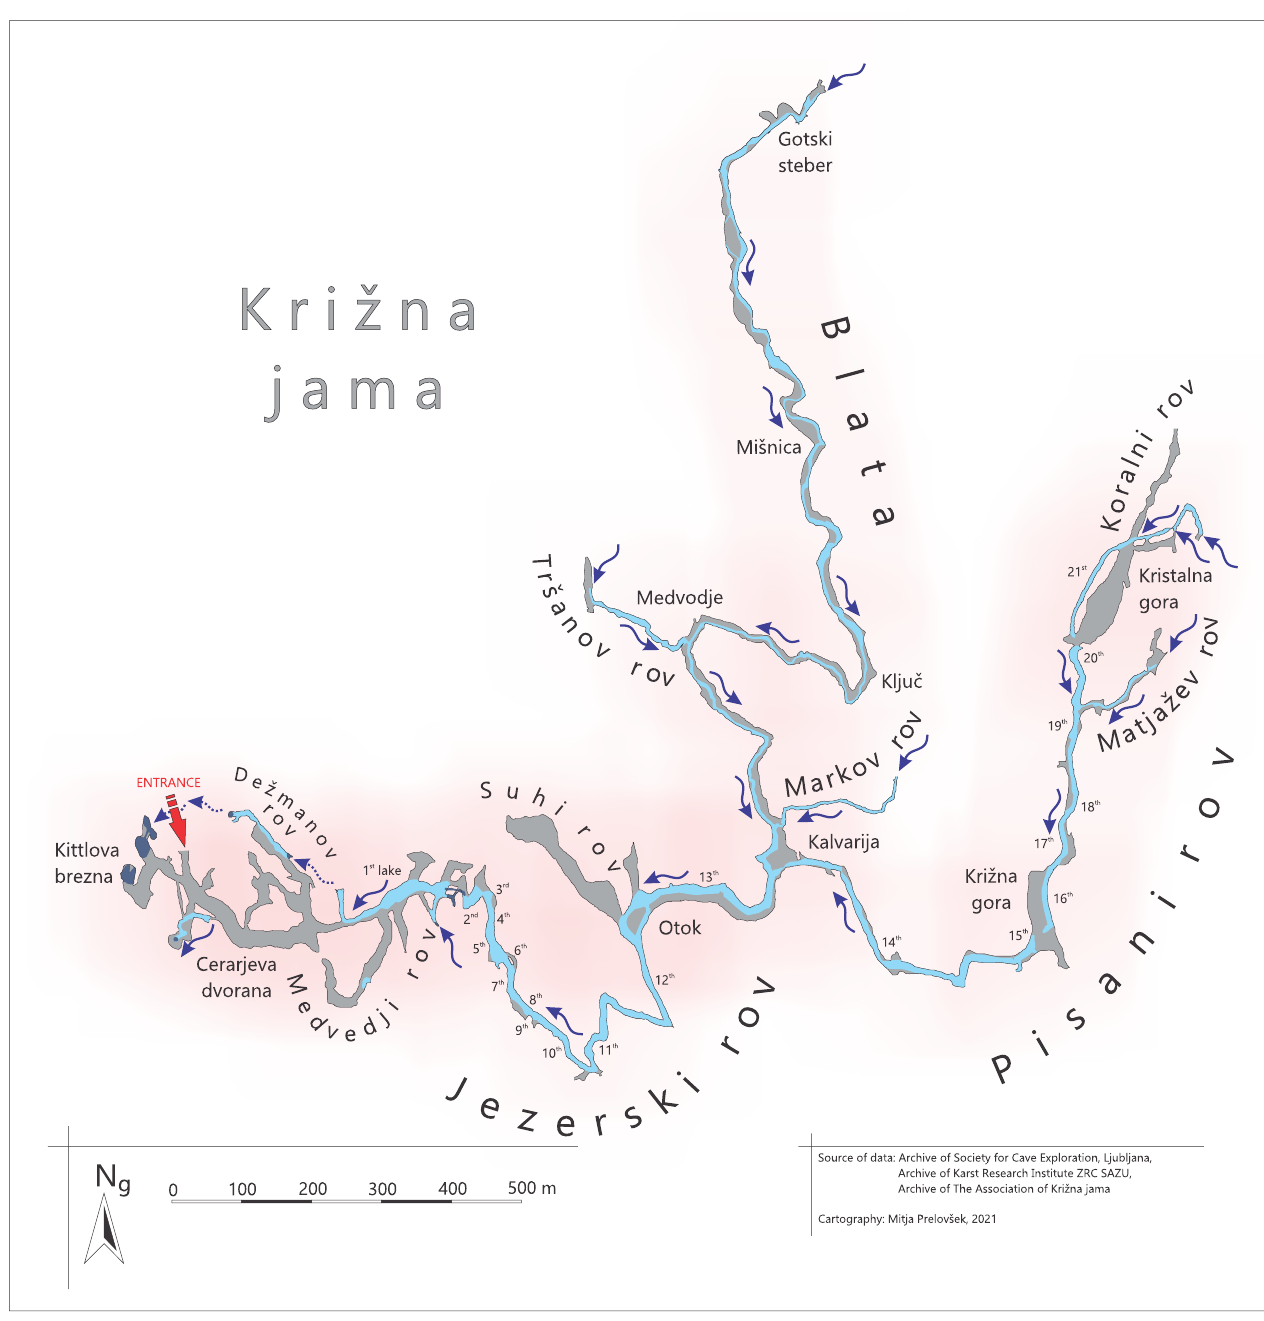
Figure 2. Plan of Križna jama. Archive of Karst Research Institute ZRC SAZU, cartography Mitja Prelovšek. Križna jama crystal clean lakes and dripstone formations attracted numerous explorers, cavers and visitors early in the 20th century. Uncontrolled visits in the early time resulted in some damage of dripstone formations and local pollution of the cave. The local cavers soon closed the entrance and within a couple of volunteer actions successfully cleaned up the cave. Križna jama nowadays accepts about 10,000 guided visitors per year, but only a small part of the visitors are lucky enough to enjoy the beautiful lakes in the inner parts of the cave by boat. Due to the fragility of the sinter dripstones and the sensitivity of the cave, the number of guided visits is limited and strictly